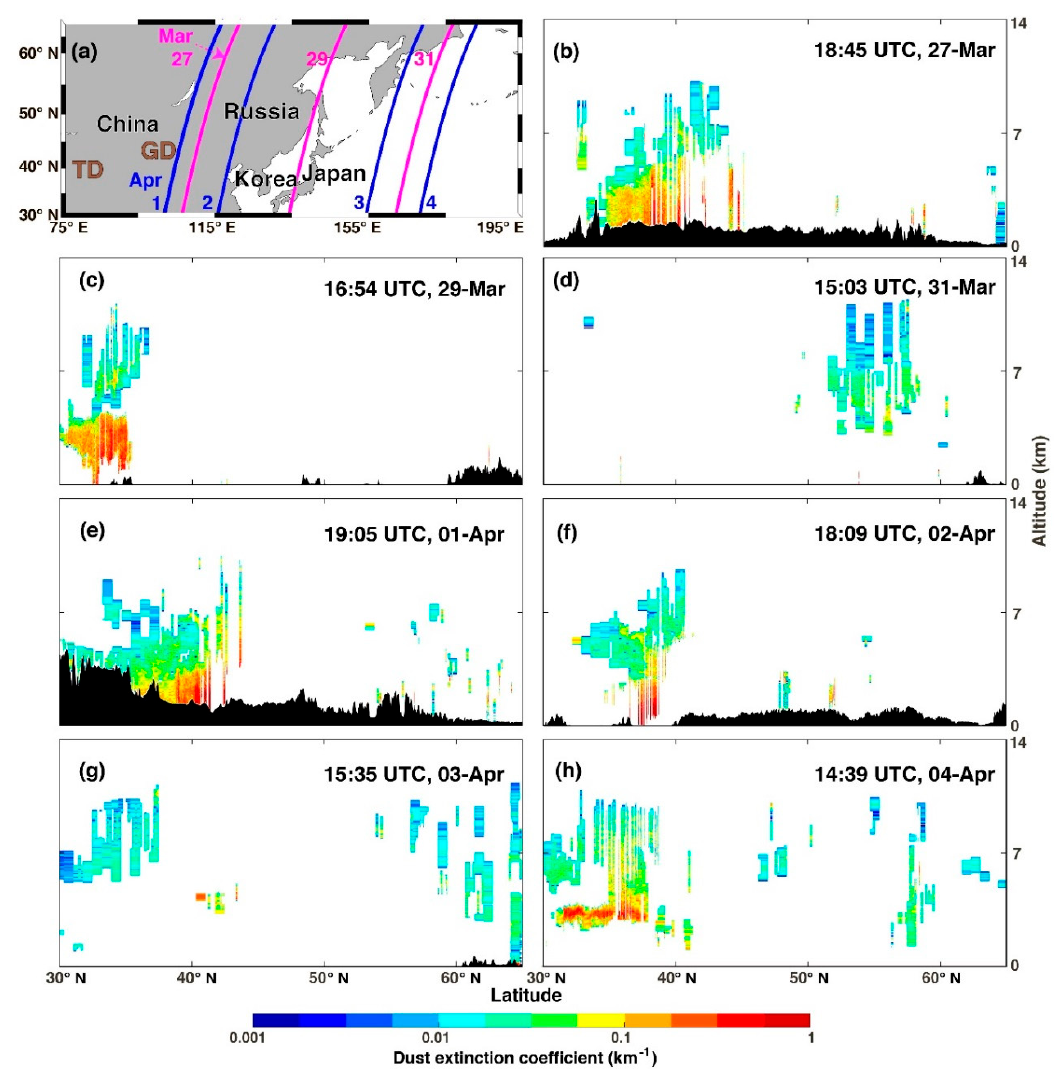
Figure 6. ( a ) CALIPSO satellite orbit paths (pink lines on March and blue lines on April); ( b – h ) Vertical profiles of the CALIPSO dust extinction coefficients at 532 nm (km − 1 ) along orbit paths shown in Figure 6a.